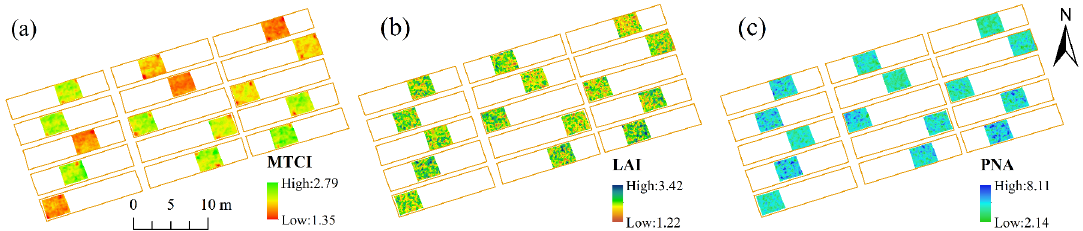
Figure 13. Scatterplots of measured and predicted ( a ) leaf area index (LAI) and ( b ) plant nitrogen accumulation (PNA) in 2019.